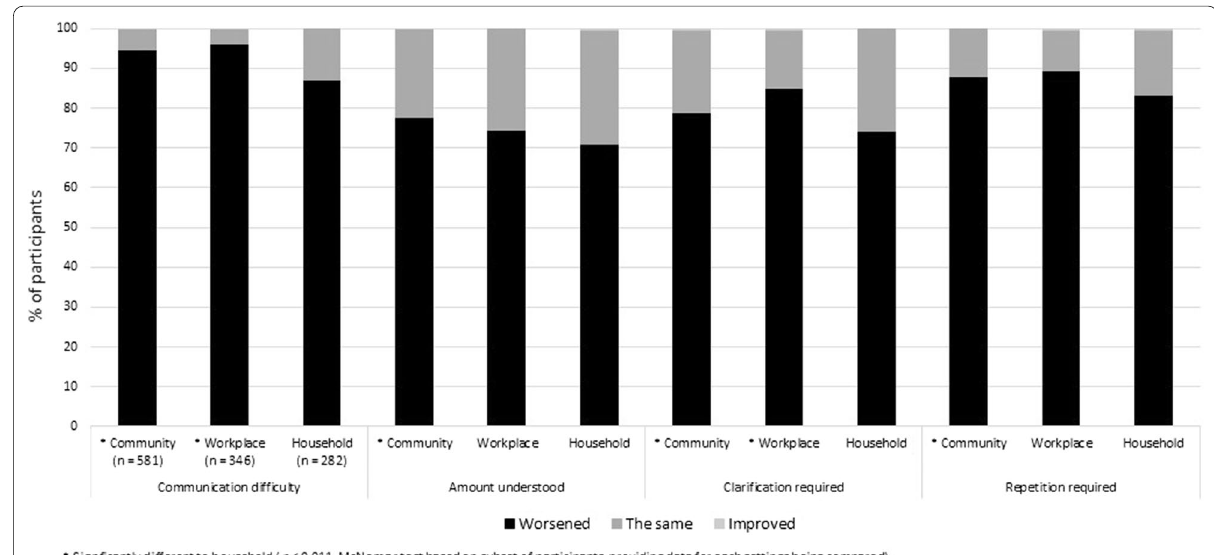
Fig. 2 Percentage of participants reporting face mask use by other people was very or somewhat influential on communication quality who reported a worsened, the same, or improved impact on four measures of communication quality when communicating in the community ( n 581), in the workplace ( n 346), and with household members ( n 282) = = =